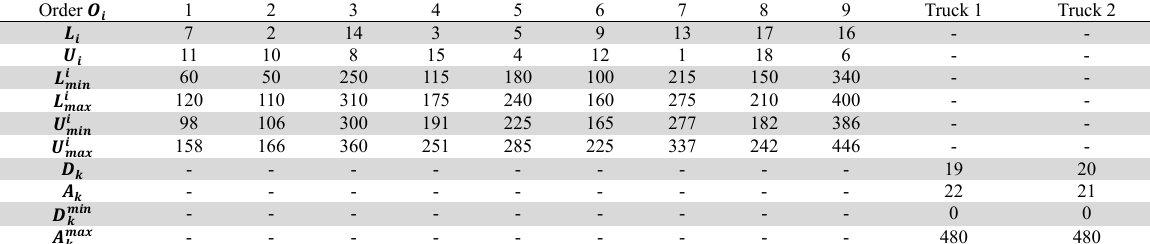
Pickup and delivery points, time windows of the orders (WTW=60 minutes), departure and arrival points, earliest departure and latest arrival times of the two trucks